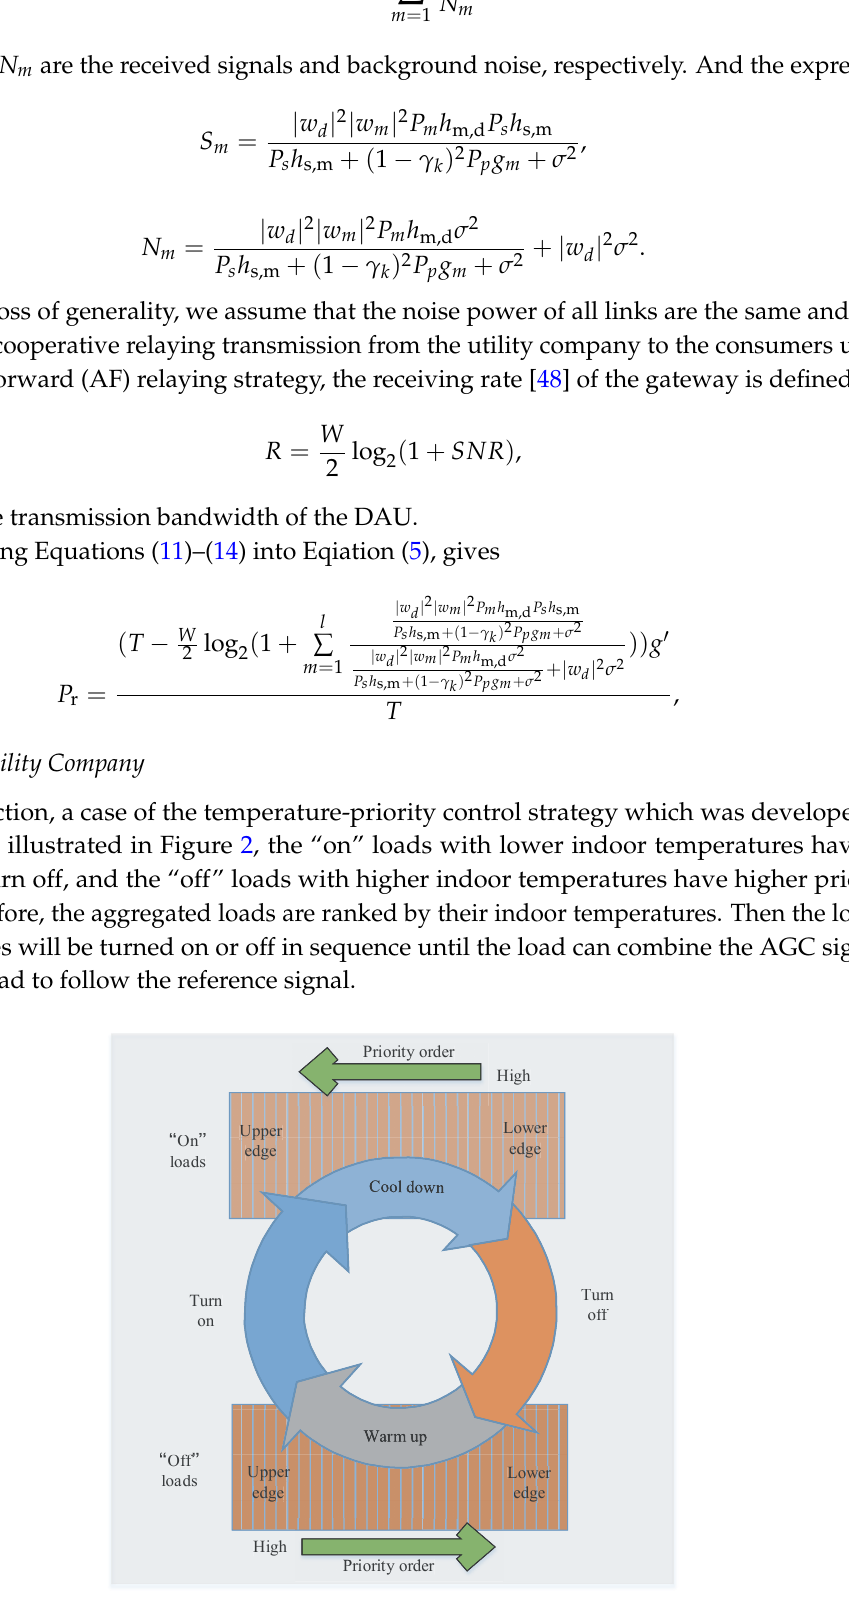
Figure 2. Temperature-priority control